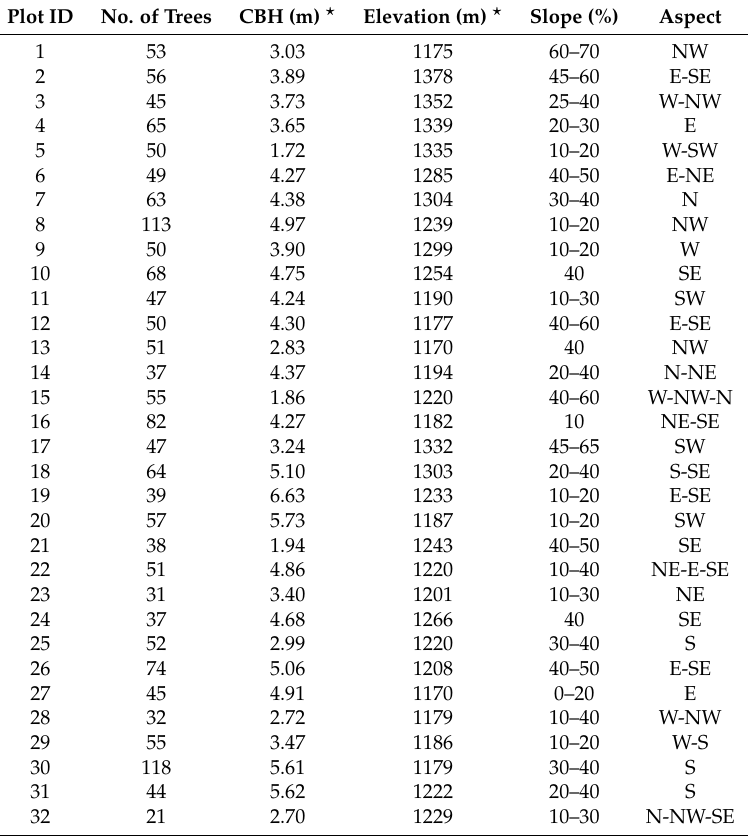
Figure 1. Study area map including vegetation cover distribution (source: forest management plan of the year 2018) and sample plots location. Table 1. Summary of field plots used in this